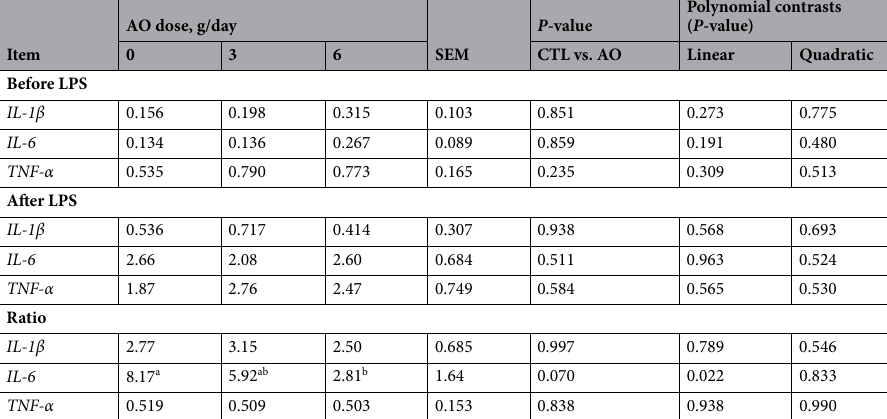
Table 3. Relative gene expression of cytokines before and after ex-vivo lipopolysaccharide (LPS) stimulation of whole blood taken from lactating heat-stressed cows fed different doses of an Aspergillus oryzae (AO) postbiotic on day 26 of the study. Data are least squares means (LSM) ± SEM. CTL control treatment, IL- 1β interleukin 1β, IL-6 interleukin 6, TNF-α tumor necrosis factor-α, Ratio ratio of after-to-before LPS stimulation. a,b Superscripts denote AO dose differences among LSM (0.05 < P ≤ 0.10). CTL vs. AO denotes contrast between CTL and AO postbiotic. Data were log transformed for statistical analysis and non- transformed LSM are reported.